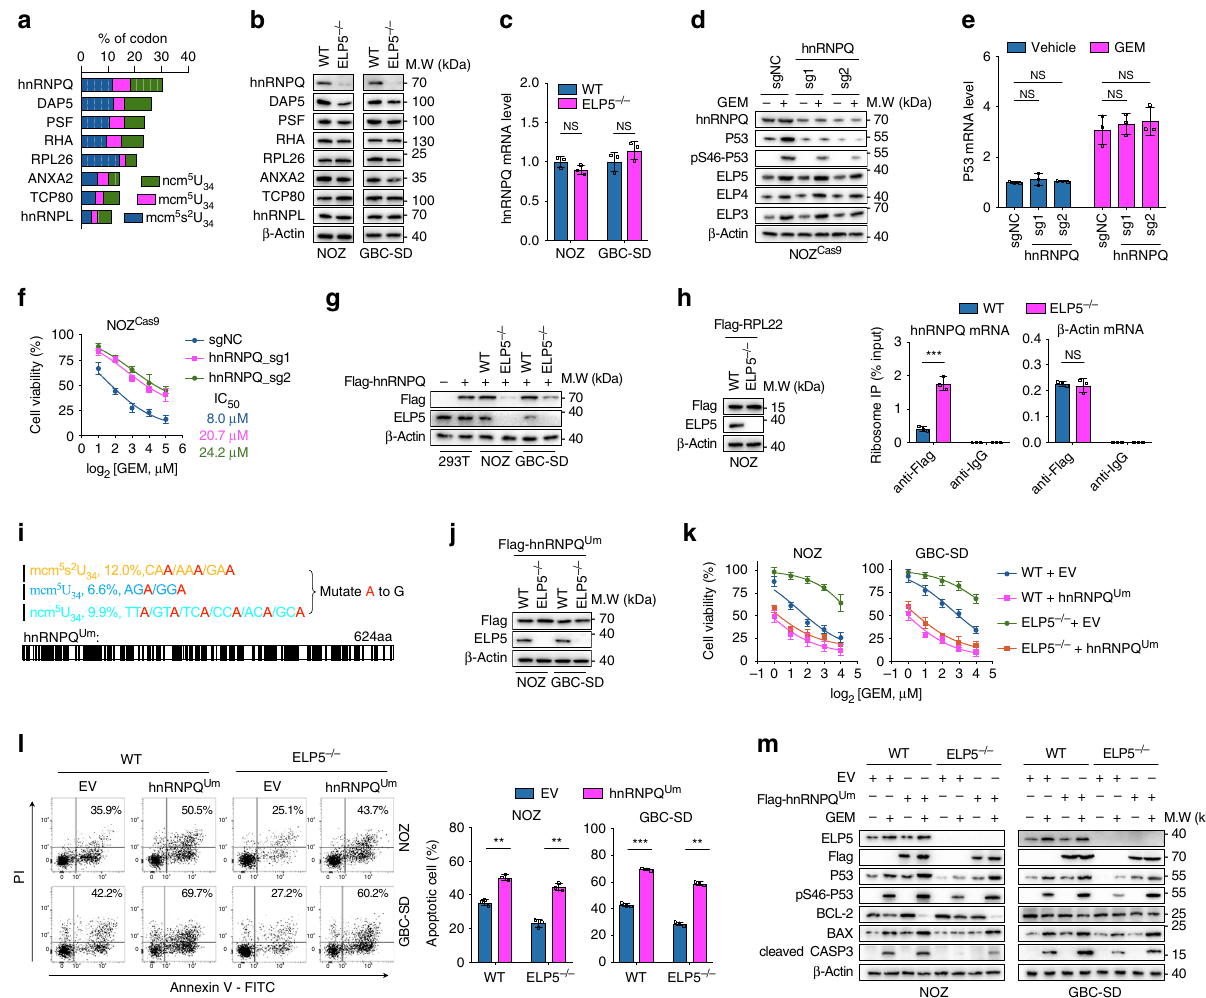
Fig. 6 ELP5 mediates wobble U 34 tRNA modi fi cation-dependent translation of hnRNPQ. a The content of U 34 cognate codons of the hnRNPQ ORF was the most enriched in P53 ITAFs. ITAF, IRES trans-acting factor. b , c ELP5 depletion downregulated the expression level of hnRNPQ protein ( b ), but not mRNA ( c ). d , e The hnRNPQ knockout signi fi cantly reduced P53 protein expression and activation under GEM treatment ( d ), but no effects were observed in the expression of Elongator subunits ( d ) and P53 mRNA ( e ). f The hnRNPQ knockout exhibited GEM resistance in NOZ Cas9 cells. g Exogenous hnRNPQ with a WT ORF sequence was poorly expressed in ELP5 -depleted cells. h WT and ELP5 -depleted NOZ cells stably expressed Flag- RPL22 (left panel) to perform ribosome immunoprecipitation followed by RT-qPCR, and the results showed ribosome accumulation in hnRNPQ mRNAs in ELP5 − / − cells, but not in control mRNAs ( β -Actin) (right panel). i Schematic drawing of the wobble U 34 cognate codon mutation (Um) in the hnRNPQ ORF sequence (hnRNPQ Um ). j Flag-hnRNPQ Um was expressed normally in both WT and ELP5 − / − cells. k , l Successfully overexpressed hnRNPQ Um could promote or rescue GEM sensitivity ( k ) and GEM-induced apoptosis ( l ) in WT and ELP5 − / − cells, respectively. m Overexpression of hnRNPQ Um promoted P53 accumulation and activation in ELP5 -depleted GBC cells. Data represent the mean ± S.D., n = 3 independent experiments in c , e , f , h , k , l , error bars represent S.D. Unpaired Student ’ s t tests were used in c , e , h , l (NS, non-signi fi cant, ** P < 0.01 and *** P <